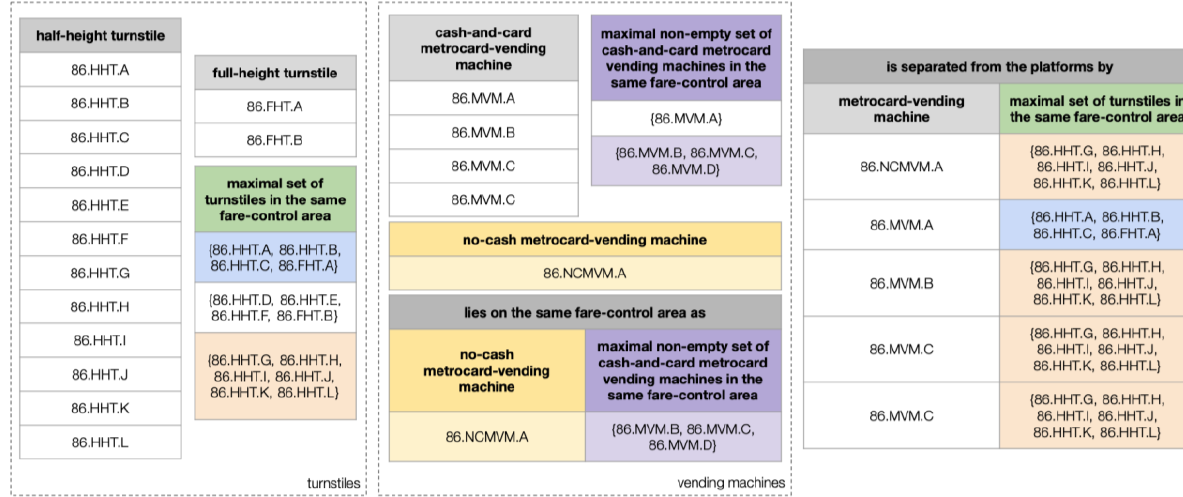
Figure 4. Instances of turnstile- and vending-machine related entities and aspects on the 86th St-Central Park West subway station. We note that there are three instances of “a maximal set of turnstiles in the same fare-control area” but only two instances of “a maximal non-empty set of cash-and-card metrocard-vending machines in the same fare-control area”, which implies that there is a fare-control area in this station where users cannot buy a new metrocard. Indeed, the image of the aspect “is separated from the platforms by” contains only two elements. Mathematically, one can argue that this aspect is not surjective (i.e. the image is not the entire codomain) if and only if such a fare-control area exists. The same aspect would be surjective in the olog designed for the 14th St-Union Square subway station.